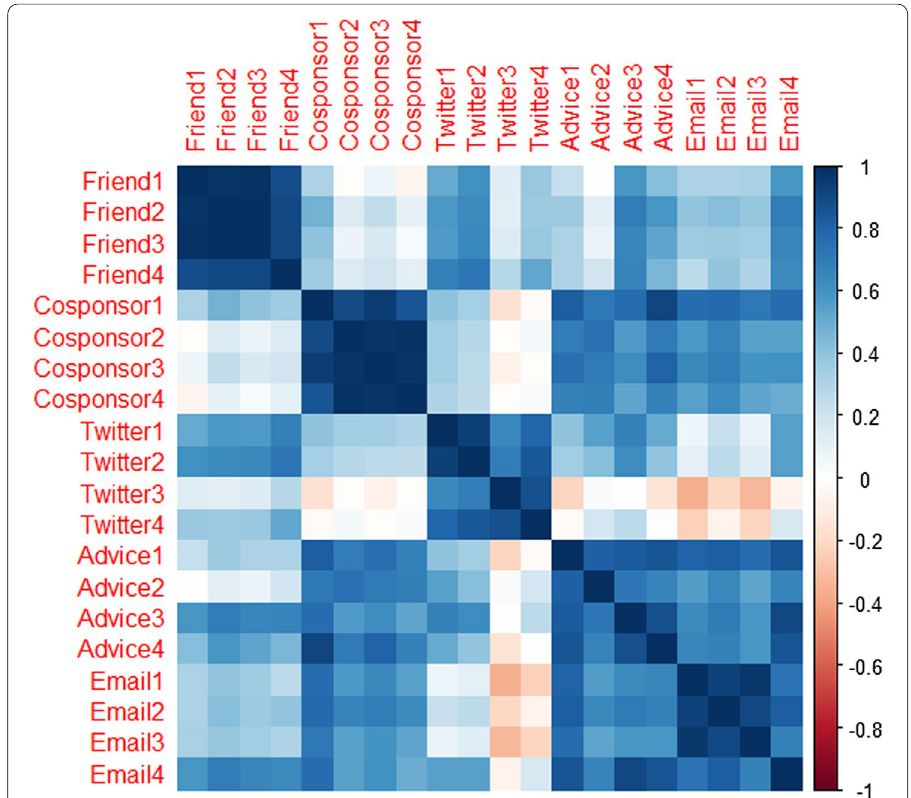
Fig. 7 Correlation plot between SRPs of directed triads and symmetric